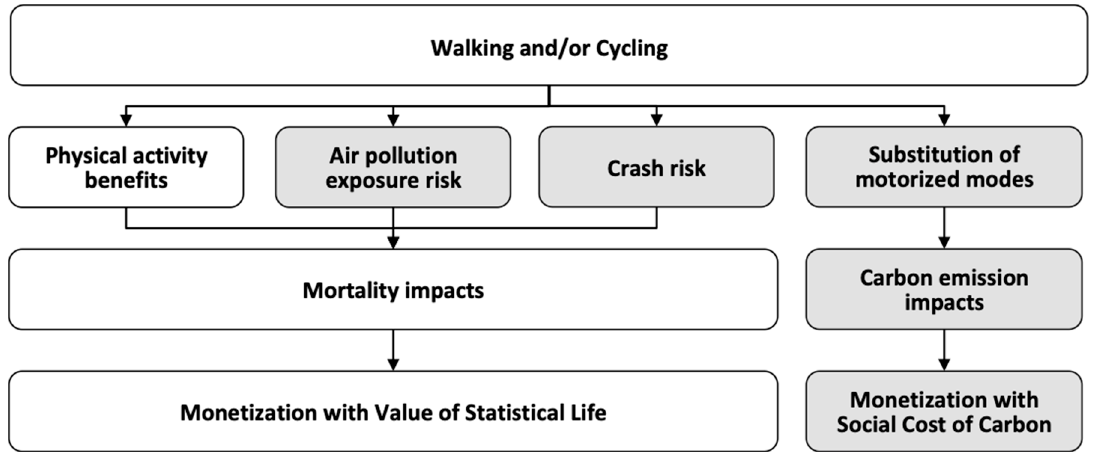
Figure 1. Impact pathways of the Health Economic Assessment Tool for walking and cycling (HEAT). Newly added pathways are highlighted in grey.